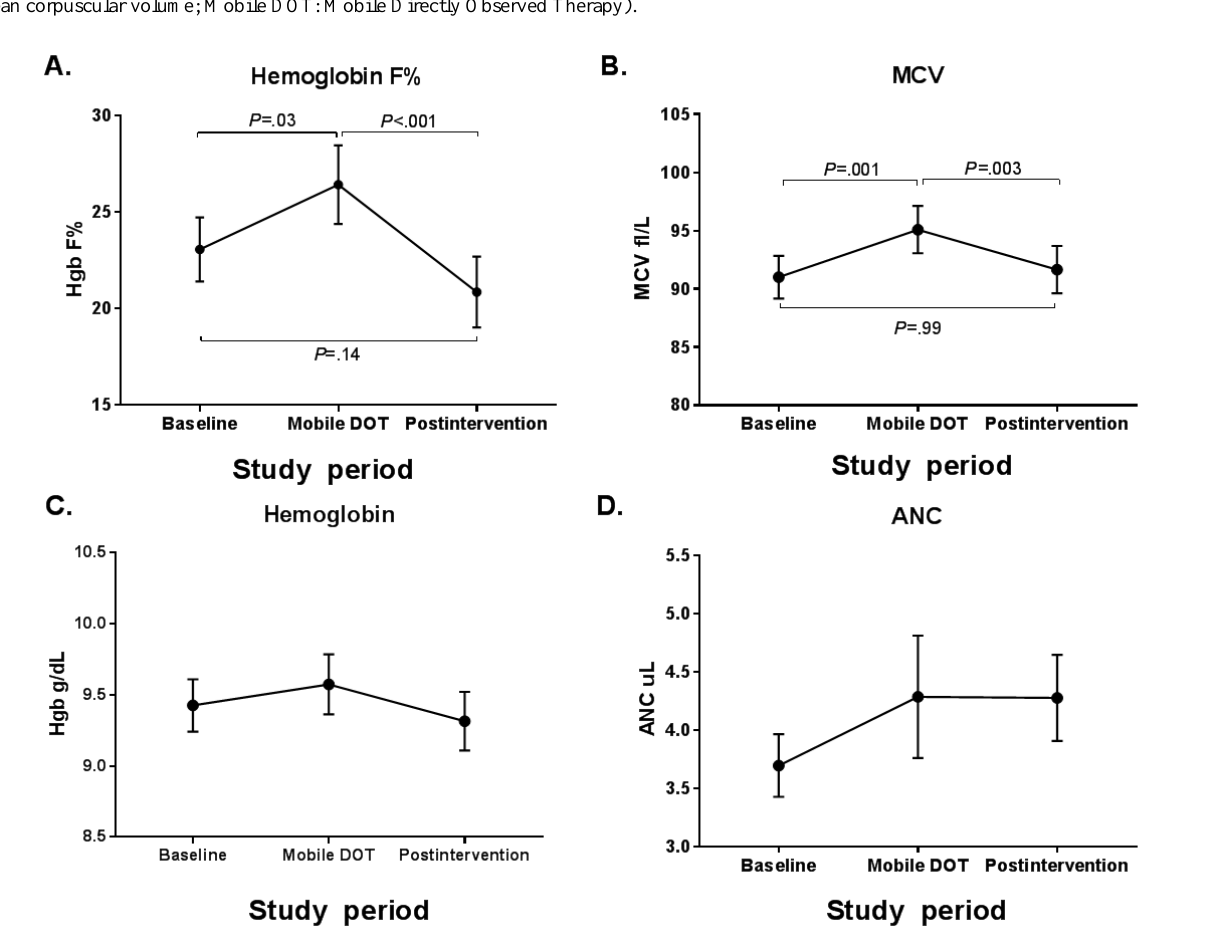
Figure 3. Engaged participants’ (n=34) laboratory studies at the end of each study period (ANC: absolute neutrophil count; Hgb: hemoglobin; MCV: mean corpuscular volume; Mobile DOT: Mobile Directly Observed